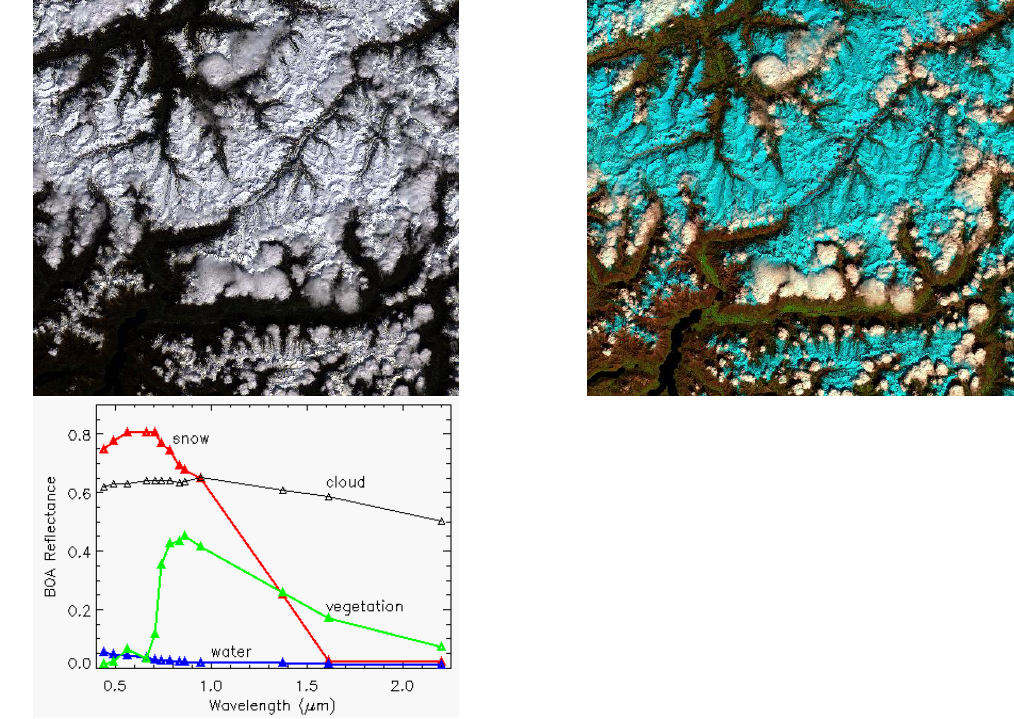
Figure 3. Left to right : true color (RGB = 665,560,443 nm) composite of scene ID 19, SWIR1 (RGB = 1600,860,660 nm) composite and example